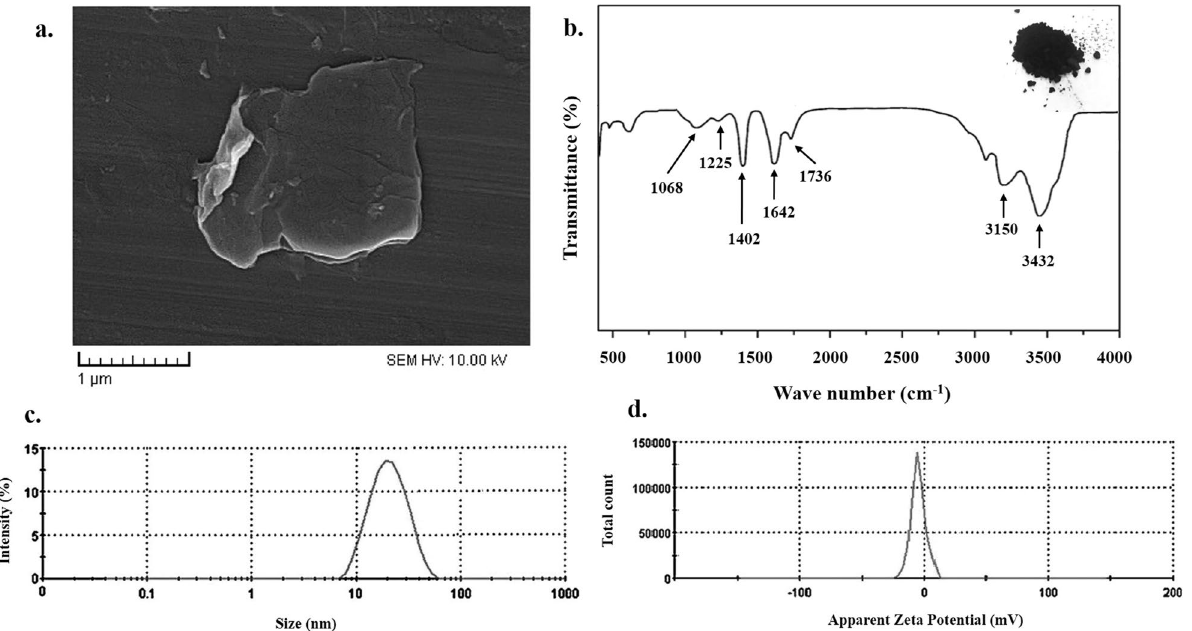
Figure 3. Characterization of synthesized NGO: ( a ) Micrograph of field emission scanning electron microscopy (FESEM); NGO with transparent rippled silk-like waves or a flaky, scale-like, layered structure, and wrinkled edge. ( b ) Fourier-transform infrared (FTIR) in the range of 500–4000 cm −1 , the peaks at 1402 cm −1 and 3432 cm −1 indicate the vibrational bands of O–H. C–O stretching, C=C stretching, and C=O stretching are observed at 1225 cm −1 , 1642 cm −1 , and 1736 cm −1 , respectively. ( c ) Average particle size distribution of NGO